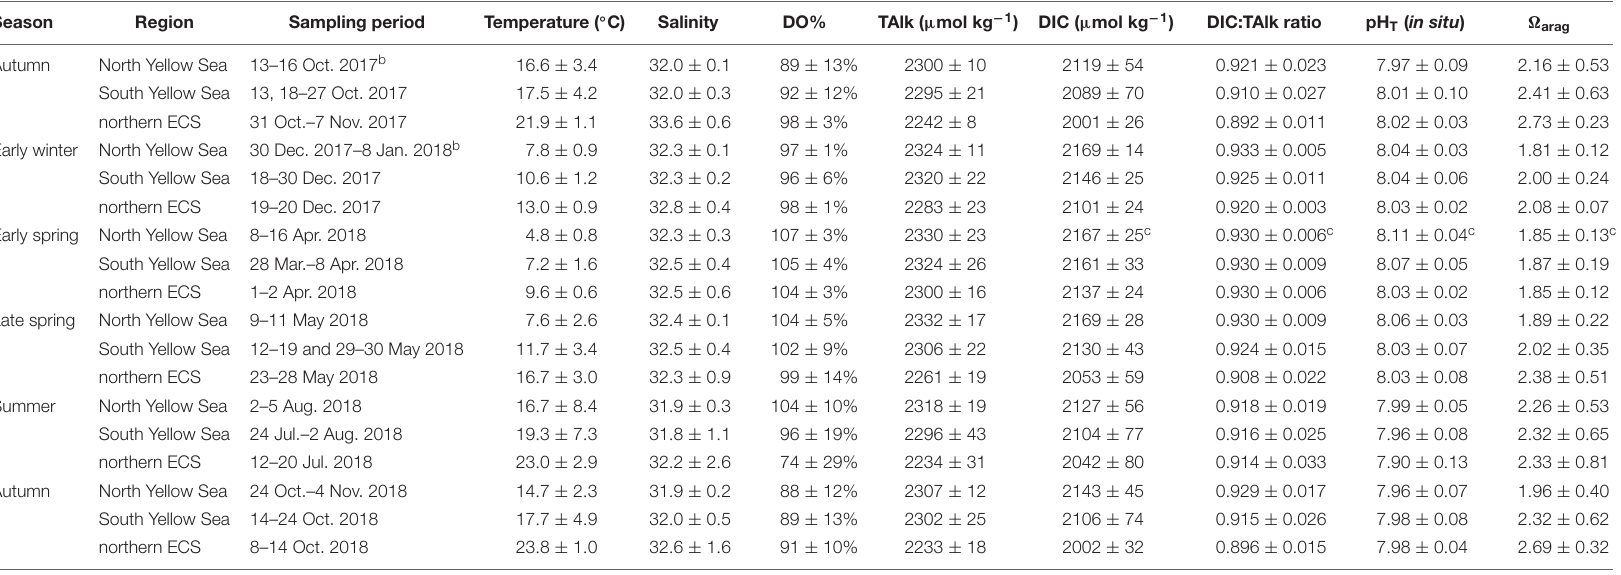
TABLE 1 | Summary of field data of water temperature, salinity, DO saturation (DO%) and carbonate system parameters a . Season